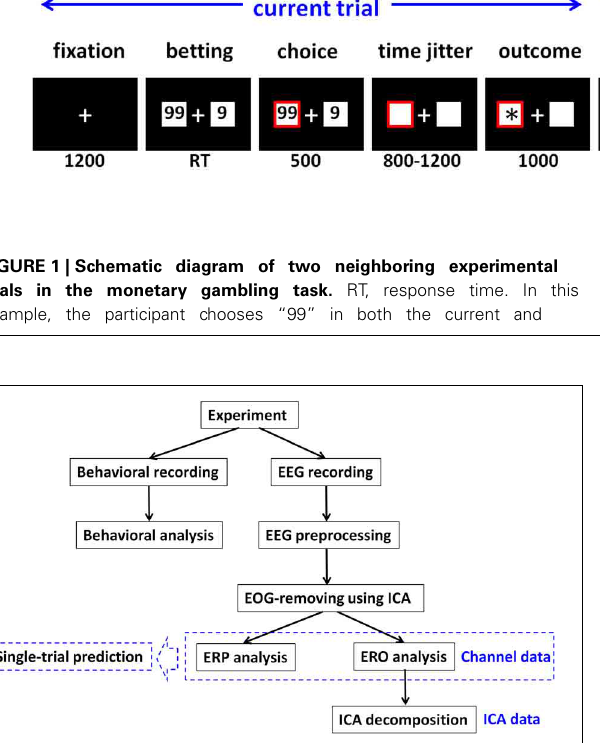
FIGURE 2 | The procedure of data recording and analysis in this